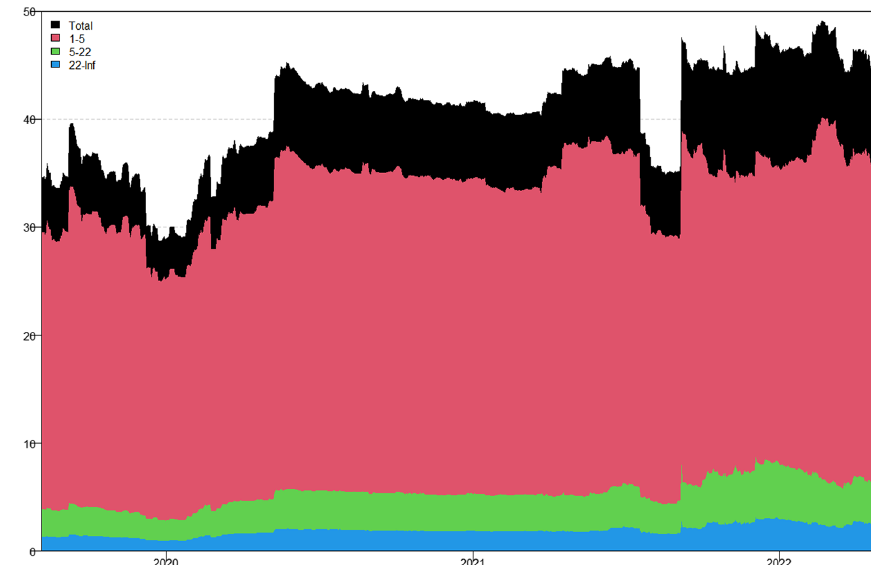
Fig. 33 Dynamic total RS connectedness—robustness